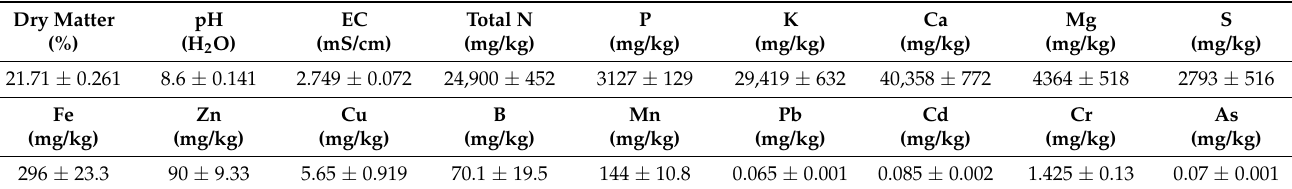
Table 2. Specifications of applied SPD in dry mass.